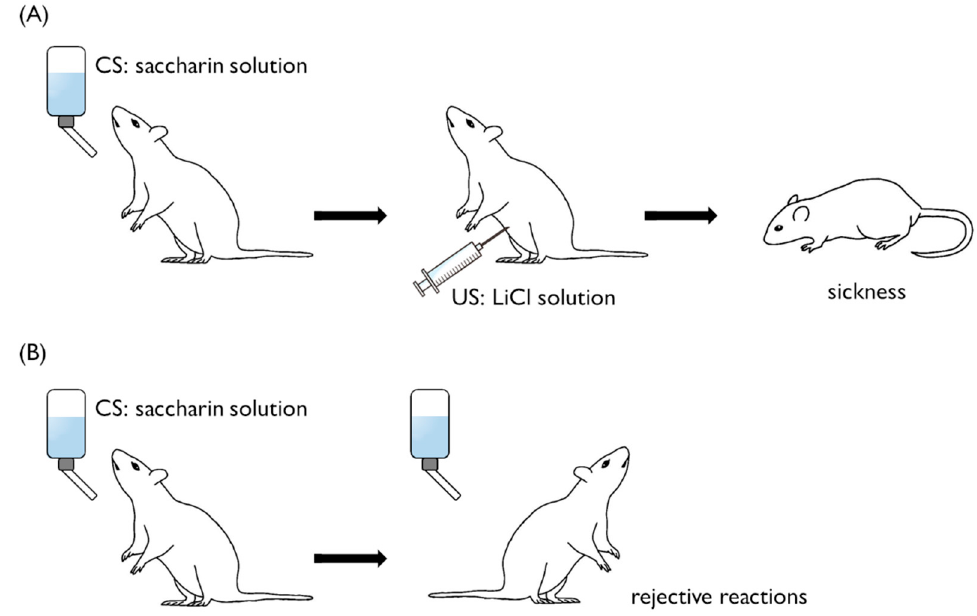
Figure 1. Training protocol of conditioned taste aversion in mammals. ( A ) Rats receive a saccharin solution (CS) followed by injection of LiCl (US). NaCl is used as a control solution for LiCl. ( B ) After CS–US pairing, rats injected with LiCl following access to a saccharin solution consume significantly less saccharin solution than NaCl-injected controls.